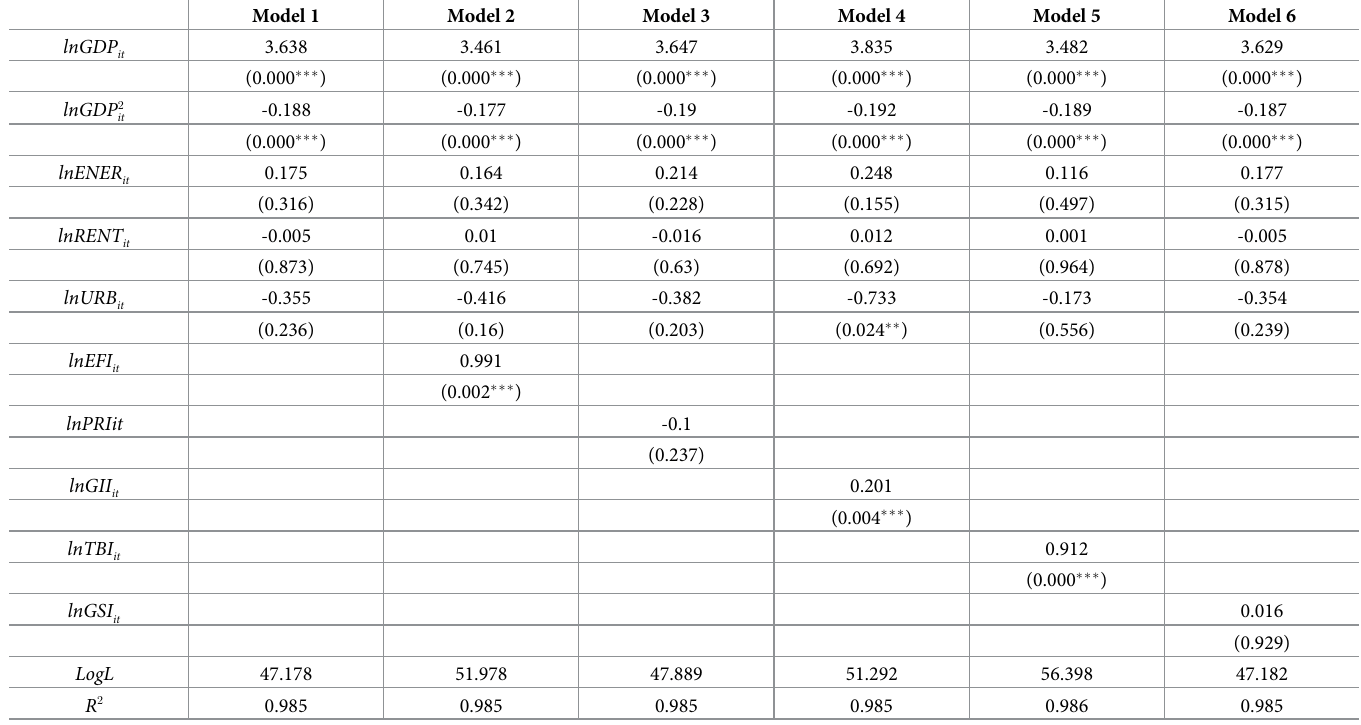
Table 5. Estimation results of PFMOLS Model 1–6 (when the variable included are